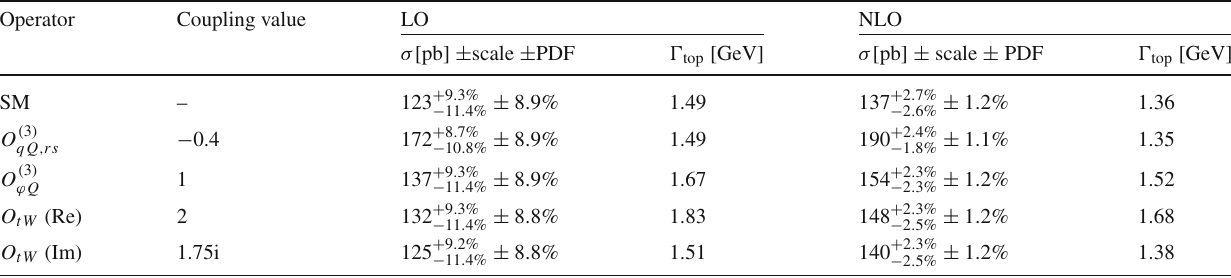
Table 2 The benchmark choices for the coupling values of the effective operators, together with the corresponding t -channel single top cross section and the width of the top quark. The scale and PDF uncertainties of the cross sections are also shown Operator Coupling